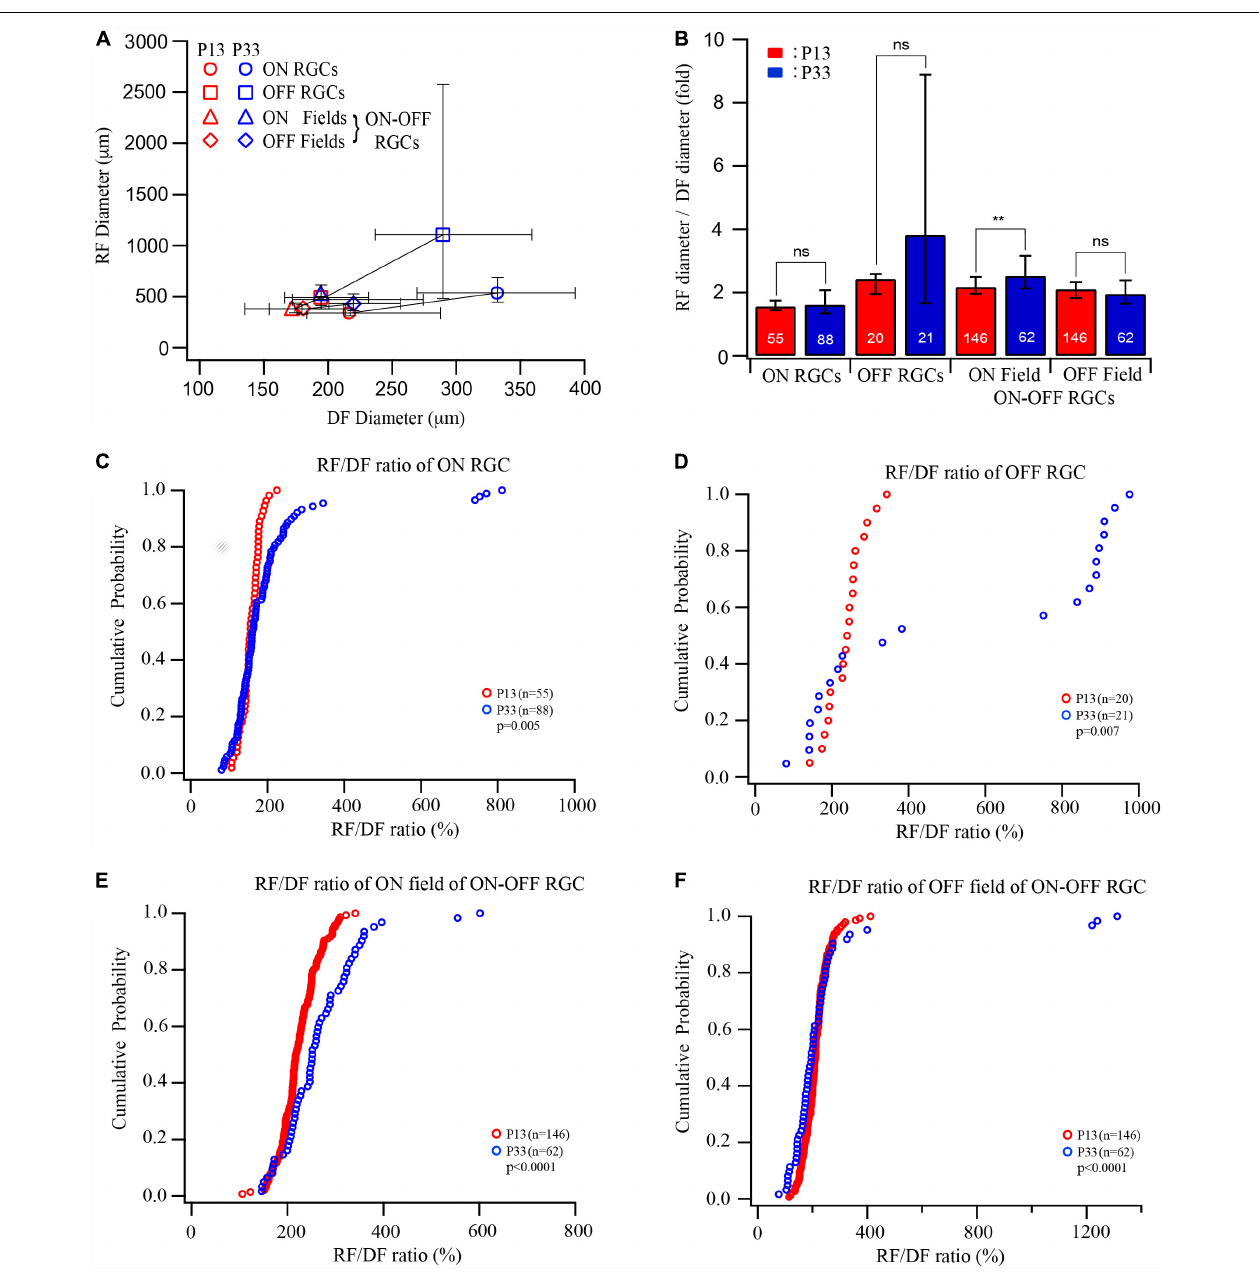
FIGURE 3 | The developmental enlargement of the dendritic and receptive fields develops differently for three RGC groups. (A) Median diameters of receptive field plotted as a function of the median diameters of dendritic fields of ON, OFF, and ON–OFF cells of P12/13 and P33 mice. Error bars indicate IQR. (B) The ratio of the median diameter of the receptive/dendritic field of ON, OFF, and ON–OFF cells of P12/13 and P33 mice. Because we did not simultaneously measure the diameters of the receptive field and dendritic field of the same RGCs in this study, we divided the receptive field diameter of each cell by the median of the dendritic field of the RGC group at the same age to calculate the ratio of receptive/dendritic field. The numbers in each bar indicate the number of cells. **0.01 > p > 0.001; ns, not significant. ( C–F) Cumulative distribution curves of the receptive/dendritic field ratios of ON, OFF, and ON–OFF cells of P13 and P33 mice. The p values were from K–S